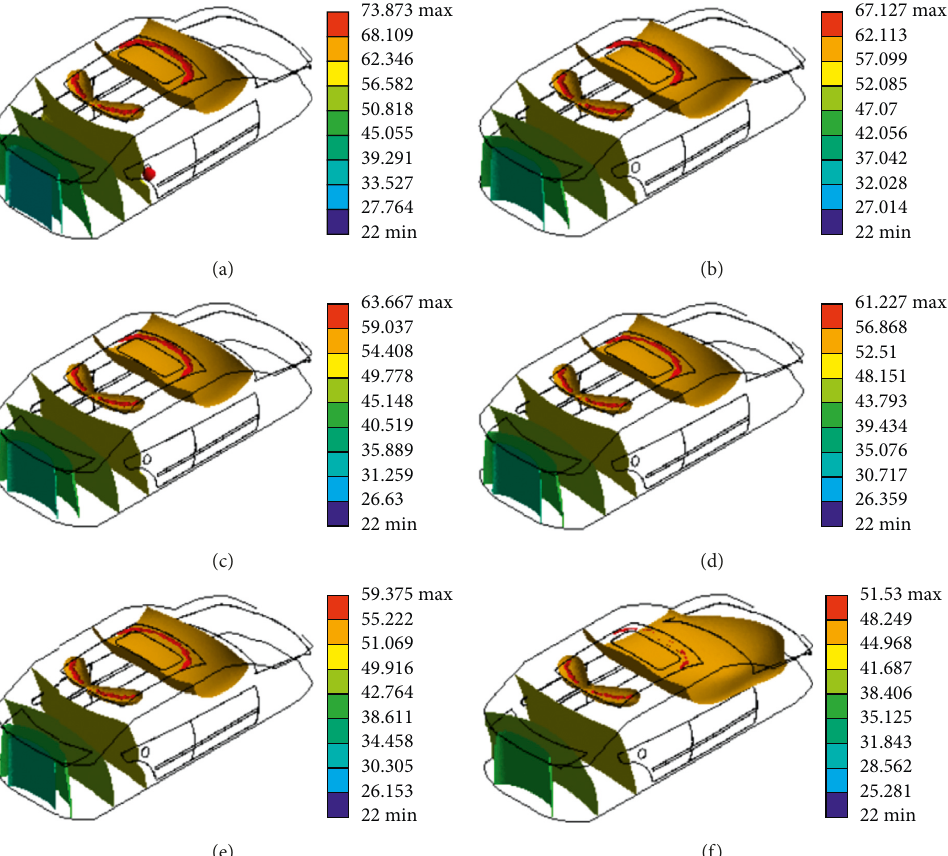
Figure 3: Temperature profiles ( ° C) for (a) reference sample 37 and (b) sample 36 and for the laminates considered as thermal barriers: (c) sample ∗ 17, (d) sample ∗ 31, (e) sample ∗ 5, and (f) sample ∗